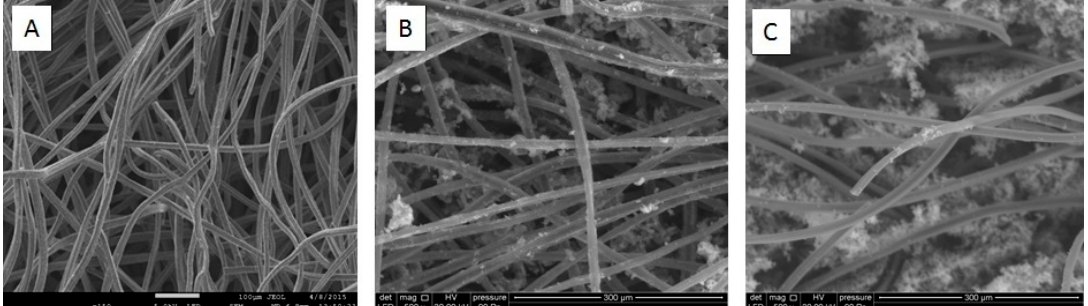
Figure 2. ESEM images of unmodified and modified carbon felt. ( A )Commercial carbon felt, ( B )